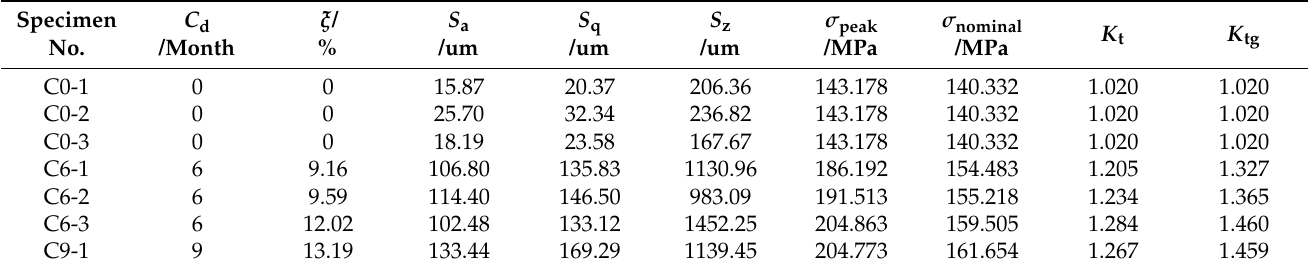
Figure 3. Three-dimensional morphology scanning results of the front side of C6-1: ( a ) 3D view of the surface, ( b ) pseudo color view of the surface, ( c ) photo copy, and ( d ) profile curve.